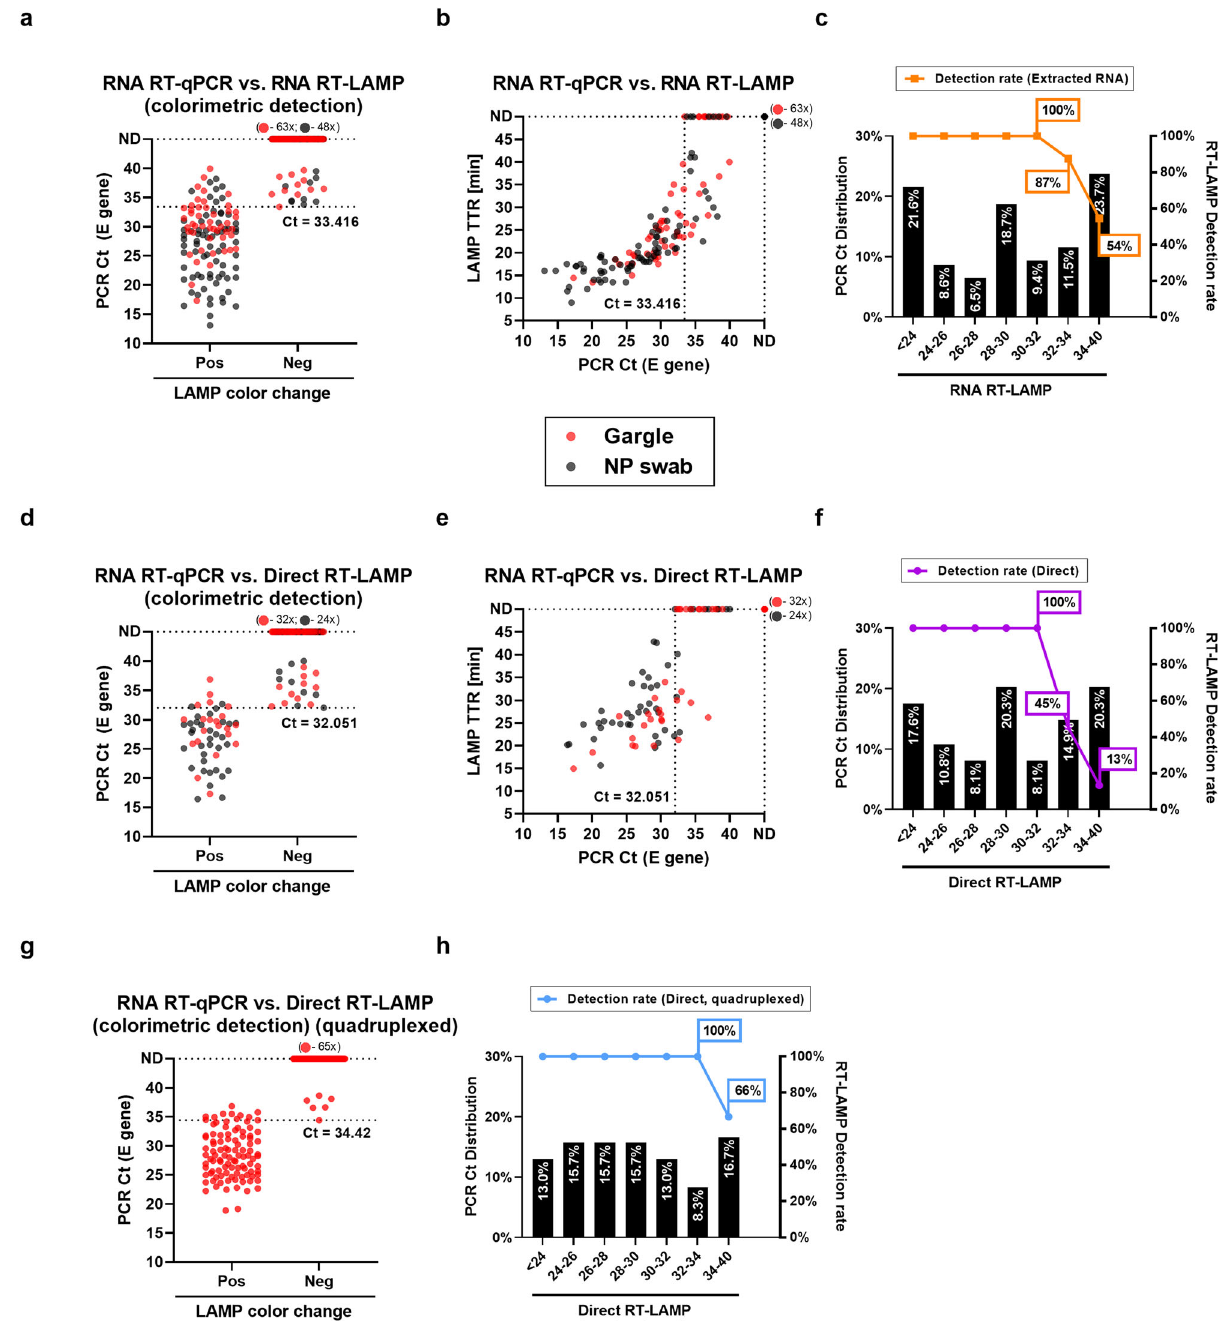
Fig. 9 Clinical performance evaluation of SARS-CoV-2 ZBP RT-LAMP and Vivid COVID-19 LAMP. Evaluation of ZBP RT-LAMP using both a colorimetric and b fl uorescent detection of extracted RNA from either clinical patient nasopharyngeal swab or gargle samples. c Detection rates of RT-LAMP relative to the distribution of RT-qPCR Ct values from samples analyzed in a and b . Evaluation of direct ZBP RT-LAMP using both d colorimetric and e fl uorescent detection of RNA, without prior RNA extraction, from either clinical patient nasopharyngeal swab or gargle samples. f Detection rates of direct ZBP RT- LAMP relative to the distribution of RT-qPCR Ct values from samples analyzed in d and e . g Evaluation of Vivid COVID-19 LAMP using colorimetric detection of RNA, without prior RNA extraction, from clinical patient gargle samples. h Detection rates of Vivid COVID-19 LAMP relative to the distribution of RT-qPCR Ct values from samples analyzed in g . The highest time to reaction value on y-axis is equal to the total duration of the reaction. ND stands for samples which did not amplify over the course of the reaction. All reactions for ZBP RT-LAMP were performed using “ ZBP 1.1 G ” reaction mix while reactions for Vivid COVID-19 LAMP were conducted using “ ZBP 2.0 ” reaction mix. Dotted lines outside of ones extending from ND ticks show the threshold for 100% detection by the tested LAMP assays. For all patient samples 1 technical replicate per 1 biological replicate was tested. Ct – PCR cycle threshold; TTR – time to reaction; NP -